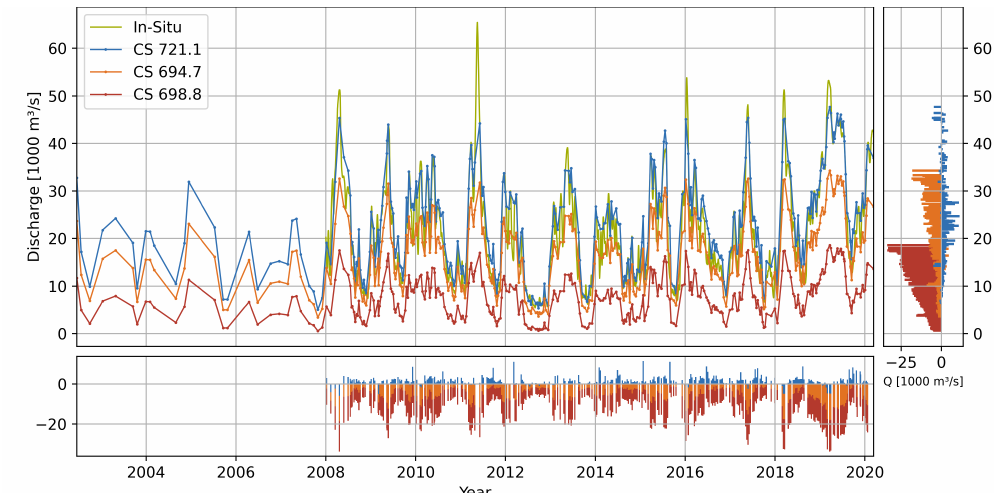
Figure 10. Discharge time series with residuals per time (horizontal) and discharge (vertical) of selected cross-sections around the Vicksburg